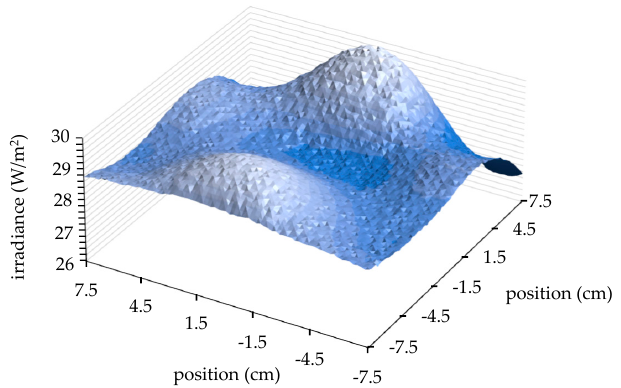
Figure 11. Measured irradiance in a 15 × 15 cm 2 target area.